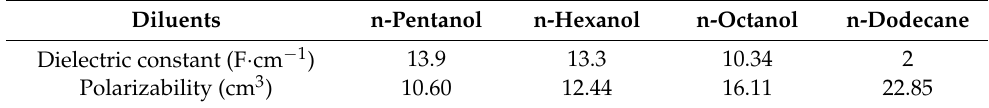
Figure 1. Effect of various diluents on the extraction of V (V) (experimental conditions: concentration of V (V) in the aqueous phase 1.75 g · L − 1 , concentration of extractant 0.2 mol · L − 1 , aqueous phase pH 8.051, extraction temperature 25 ◦ C, and equilibrium time 60 s).